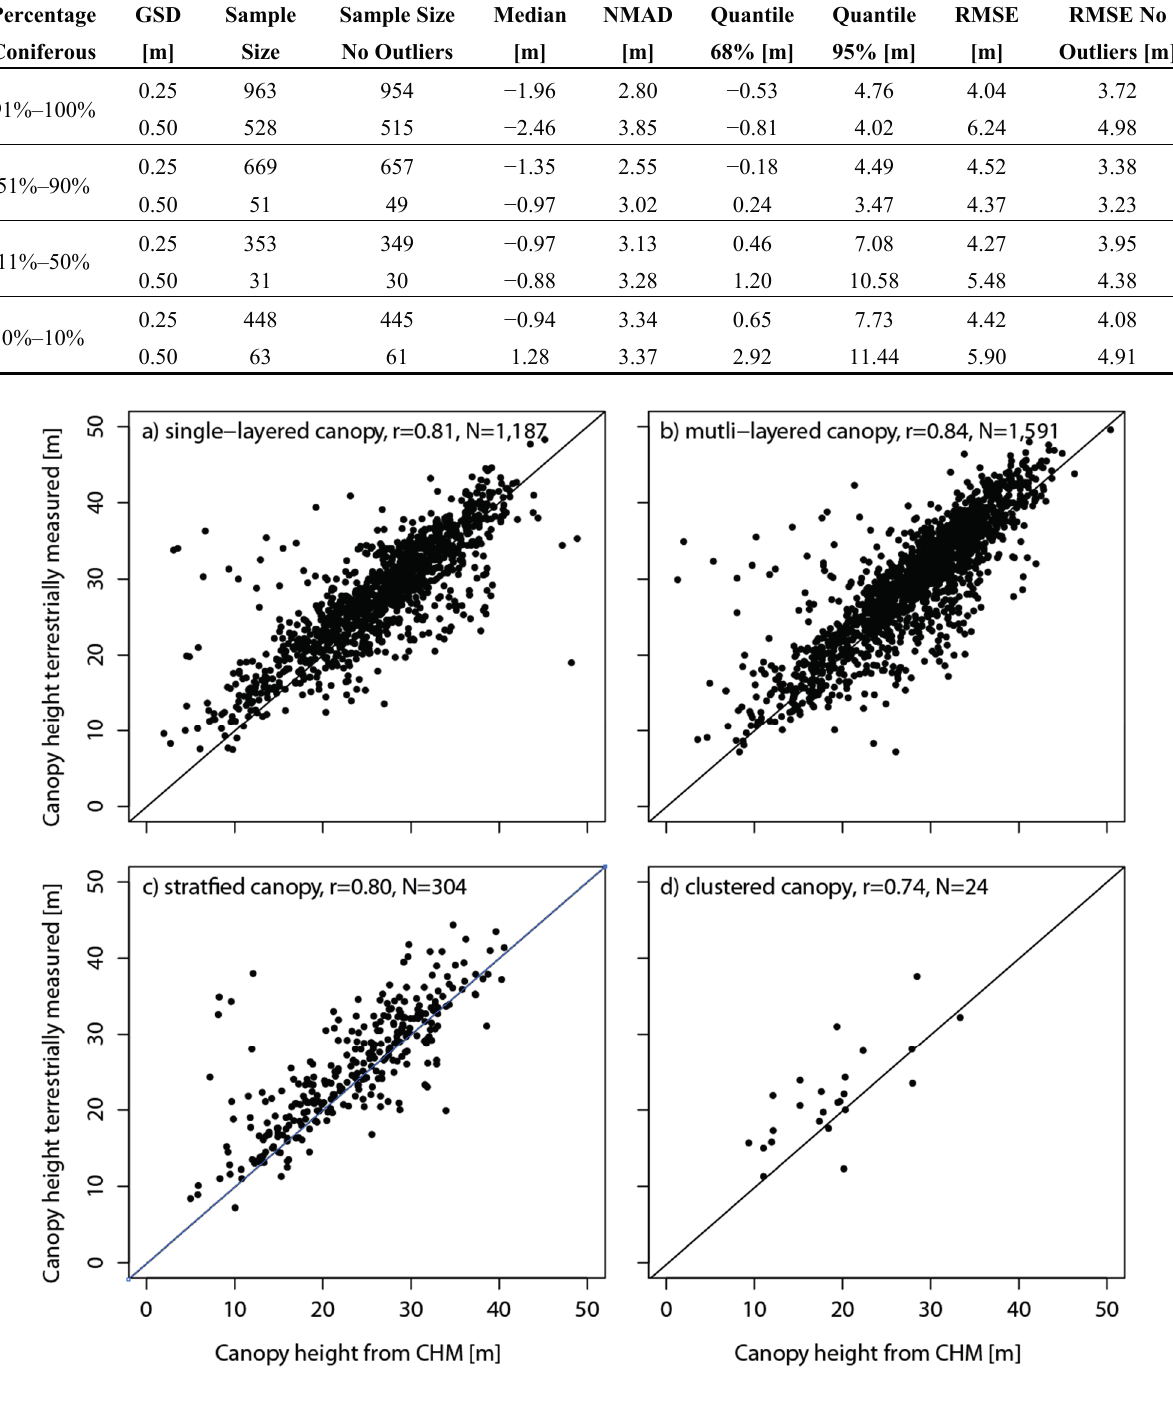
Figure A4. Comparison of canopy height of the CHM with terrestrially measured canopy height at the sample plot level of the NFI. One of the four stand structure classes ( a–d ), defined by the layering and structure of the canopy was assigned to each sample